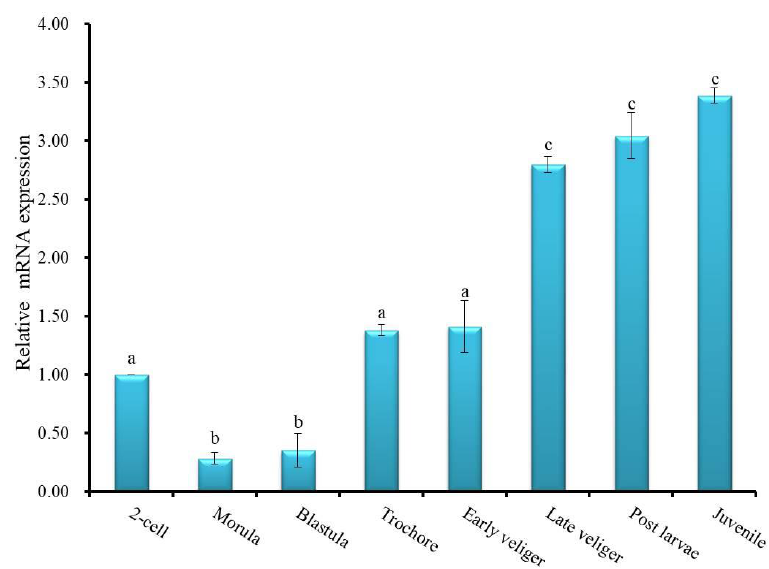
Figure 7. Relative expression levels of Hdh IGFBP7 mRNA in different developmental stages of H. discus hannai . Expression values of Hdh IGFBP7 mRNA were normalized to expression in the 2-cell stage (1). Means that do not share the same letter are significantly different.